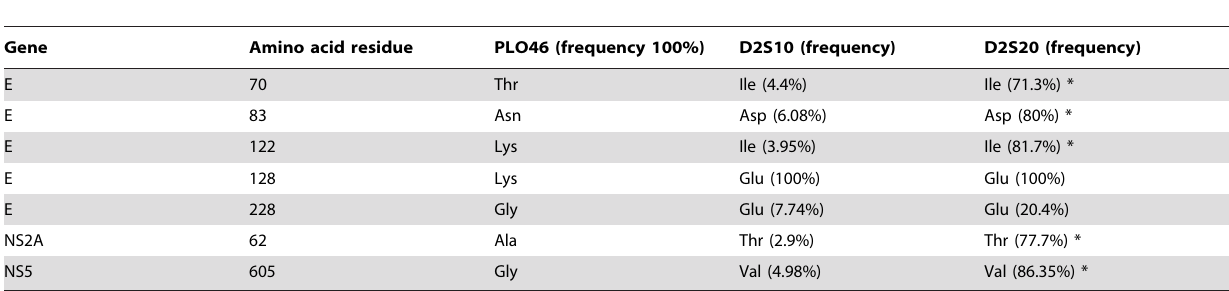
Table 1. Common amino acid changes that occur in DENV2 strains D2S10 and D2S20 relative to the parental strain PL046, but are sustained with higher frequency in D2S20 than in